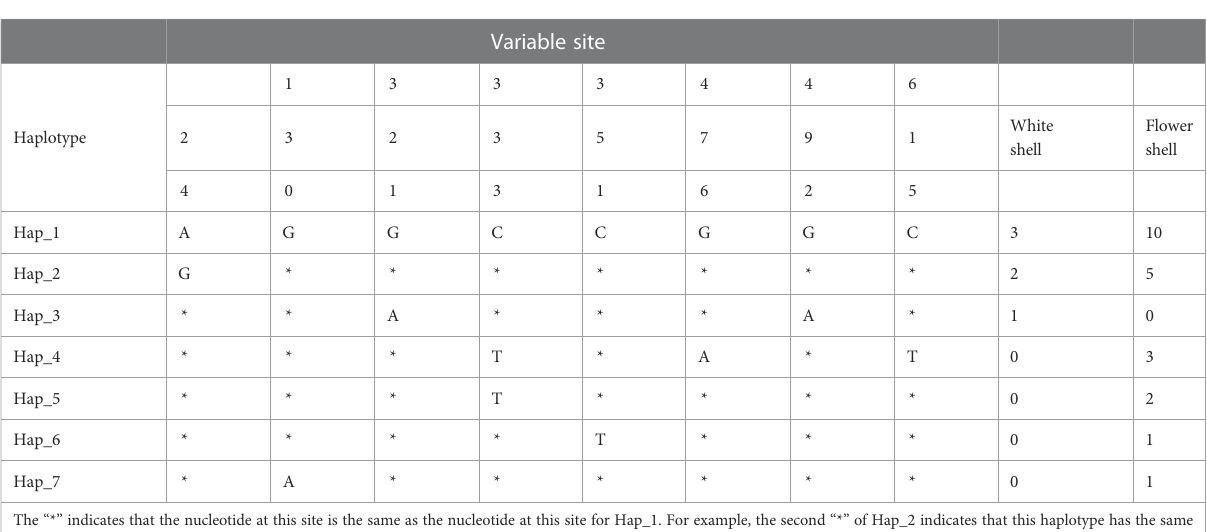
TABLE 2 Variable sites of the mitochondrial COI gene of C. tritonis .